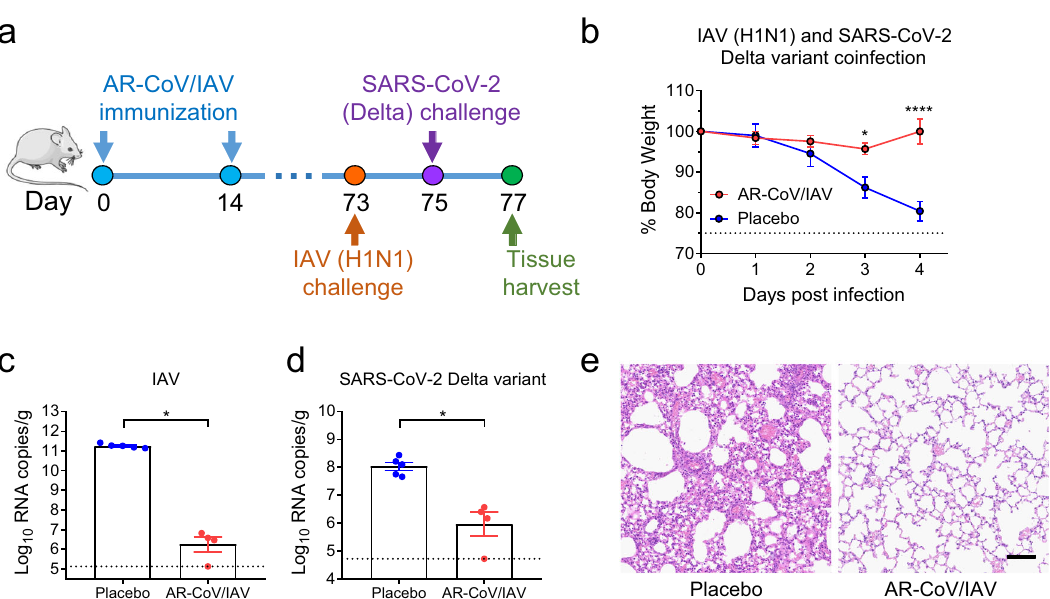
Fig. 6 AR-CoV/IAV elicits protection against coinfection with IAV and the SARS-CoV-2 Delta variant in mice. a Schematic diagram of experimental design. Groups of AR-CoV/IAV- or placebo-immunized mice were intranasally challenged with 2 × 10 5 PFU of IAV (A/California/ 07/2009) 73 days after the initial immunization, followed by infection with 1.2 × 10 4 PFU of SARS-CoV-2 Delta variant 2 days later. Mice were sacri fi ced 4 days post-IAV infection for viral detection and histopathological analysis. b Weight changes of infected mice ( n = 5) were recorded for 4 days post-infection and are shown as the mean ± SEM. c , d Viral RNA copies of IAV ( c ) and SARS-CoV-2 ( d ) in the lung tissues of infected mice (AR-CoV/IAV, n = 4; placebo, n = 5) were determined by qRT – PCR and are shown as the mean ± SEM. e Histopathologic analysis of lung sections from coinfected mice. Scale bar, 100 μ m. Data are shown as the mean ± SEM. Statistical differences were analyzed by using two-way ANOVA with multiple comparison tests or two-tailed unpaired t tests. * P < 0.05, **** P <